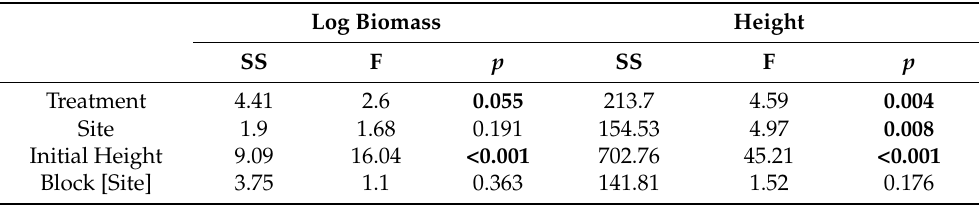
Table 4. Summary statistics for exclusion treatment (no exclusion; large mammal, small and large mammal exclusion; and full exclusion) on plant aboveground biomass (natural log transformed) and final plant height for poison ivy ( Toxicodendron radicans ) seedlings. Log